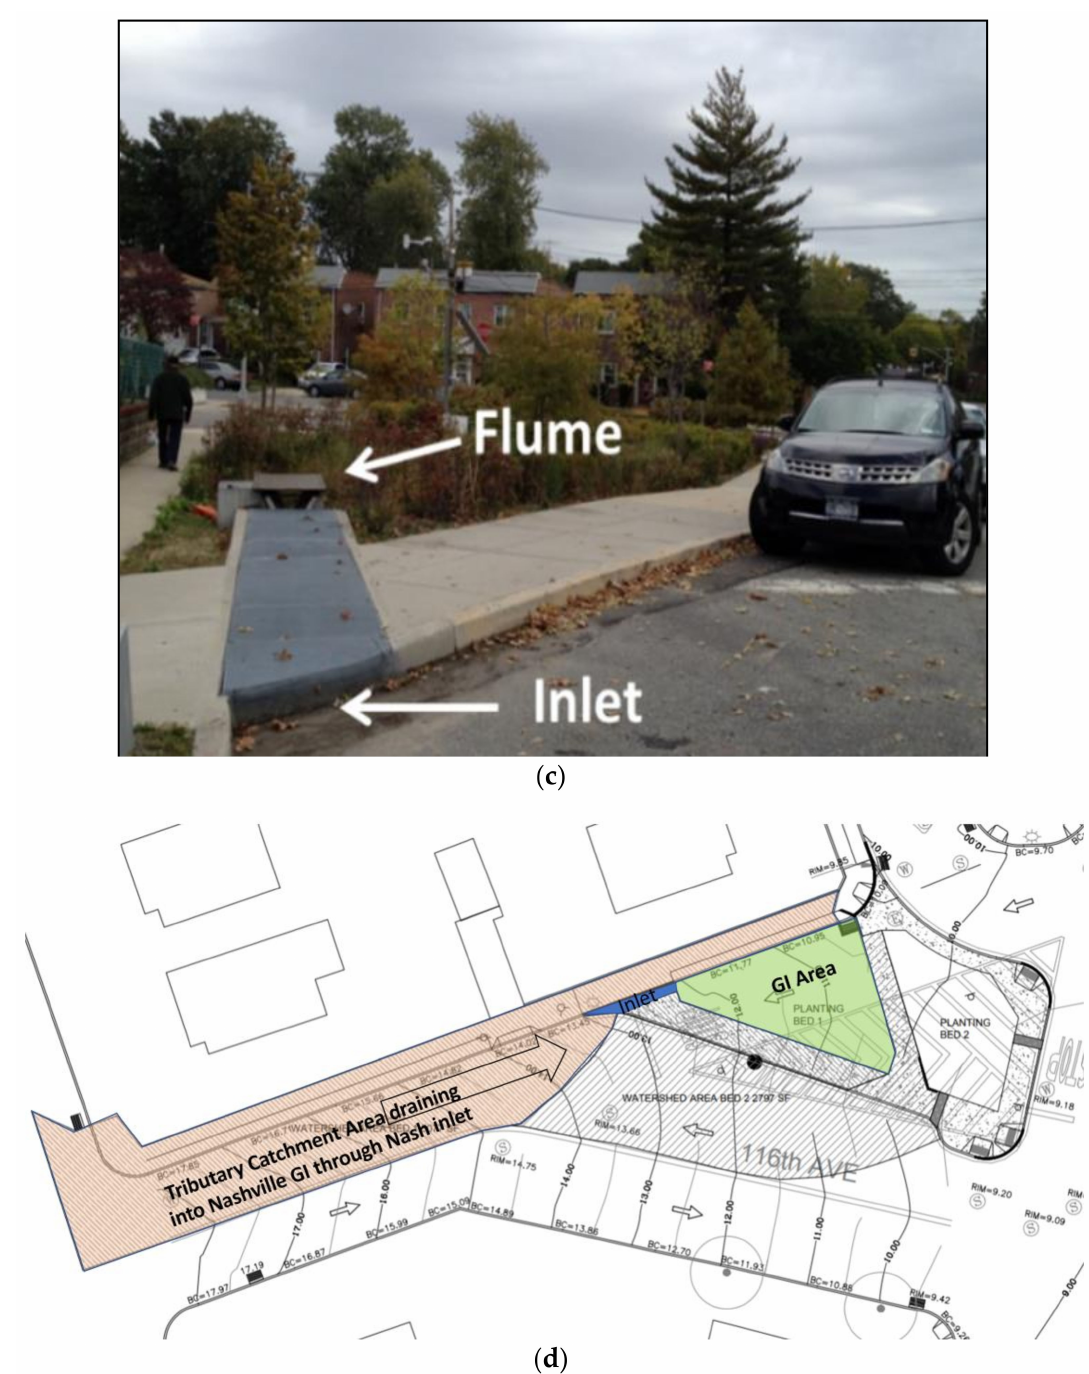
Figure 1. Inlets considered in this investigation. ( a ) photograph of SW inlet (shown by white arrow) at Happyland green street; ( b ) locations of three inlets on design drawing (plan view) of Happyland green street; ( c ) photograph of inlet at Nashville green street; and ( d ) the locations of the inlet and tributary catchment area on design drawing (plan view) of Nashville green